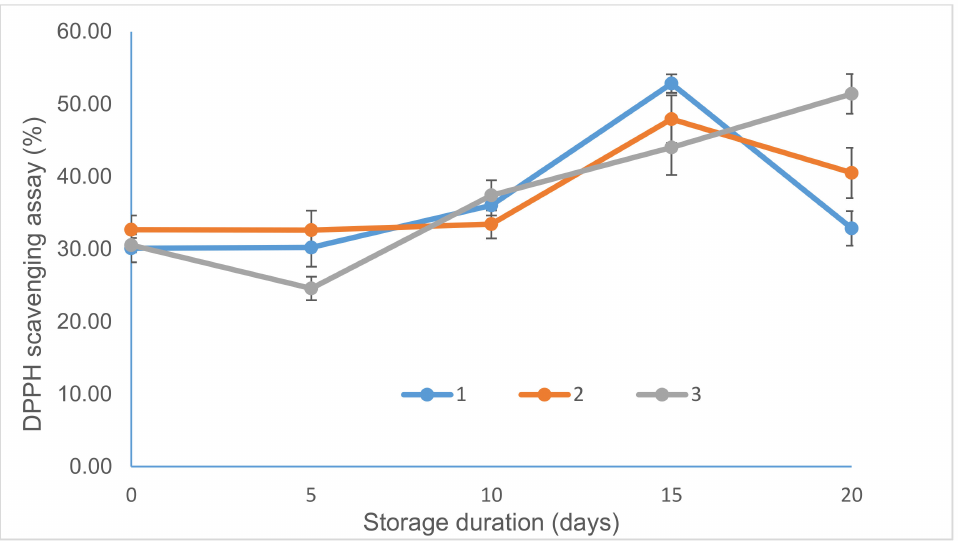
Figure 8. The interaction effects of harvesting stages (1 = green mature, 2 = breaker and 3 = half-ripe) and storage durations (0, 5, 10, 15, and 20 days) on DPPH scavenging activity (%) of tomato fruit stored at ambient temperature (28 ± 2 ◦ C and 75 ± 5%RH). Vertical bars indicate the standard error of means for 4